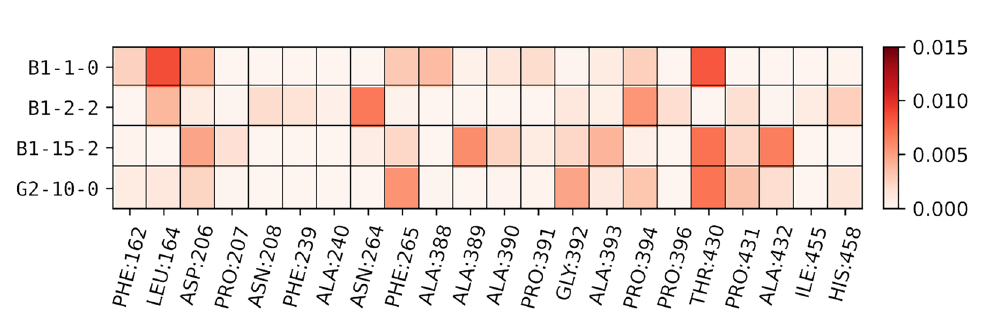
Figure 4. Interaction energies of different poses of AFB 1 and AFG 2 extracted from an MD simulation using a cluster model show no major differences between the congeners. Energies are shown for two different QM models (PBE + D3 and B97M-V).